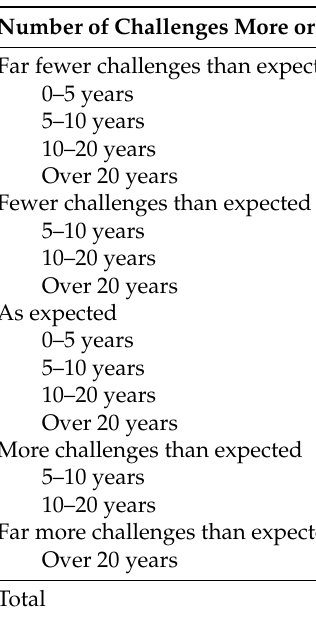
Table 11. Respondents’ views on the number of challenges, when presented with actual number in last seven years, broken down by years of experience.